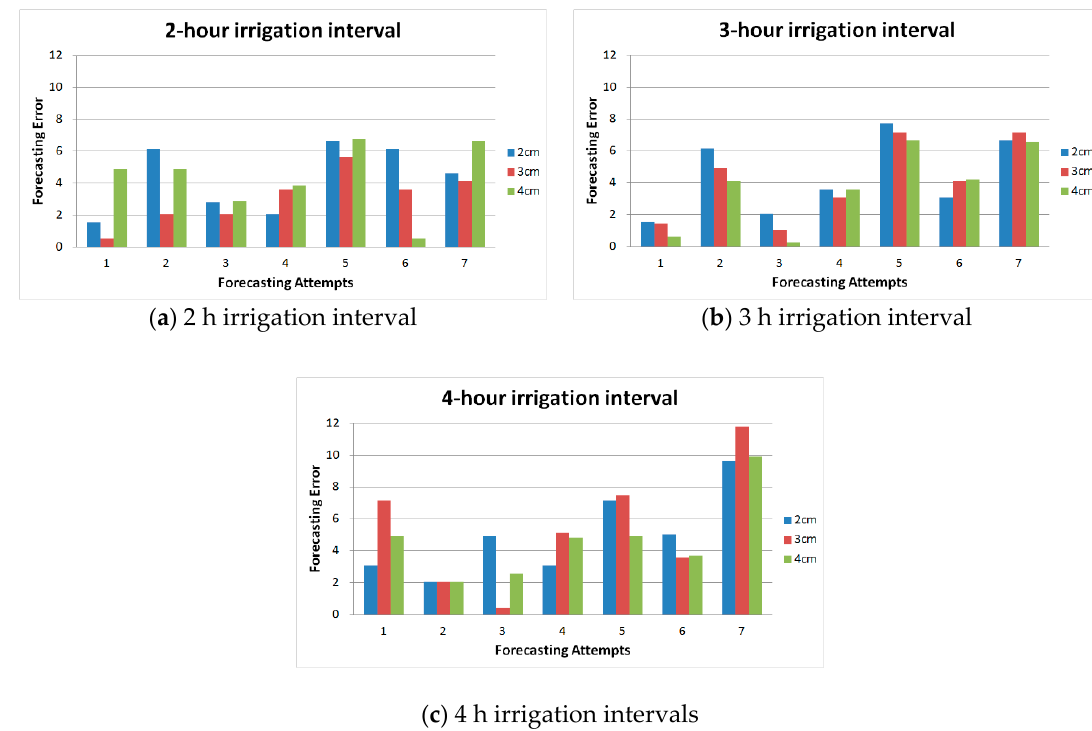
Figure 8. The continuous forecasting errors of the SMF model with the real sample results. The forecasting error is evaluated by moisture level, which is ranged from 0 to 1023. ( a ) The forecasting errors of 2 h irrigation interval. ( b ) The forecasting errors of 3 h irrigation interval. ( c ) The forecasting errors of 4 h irrigation interval.